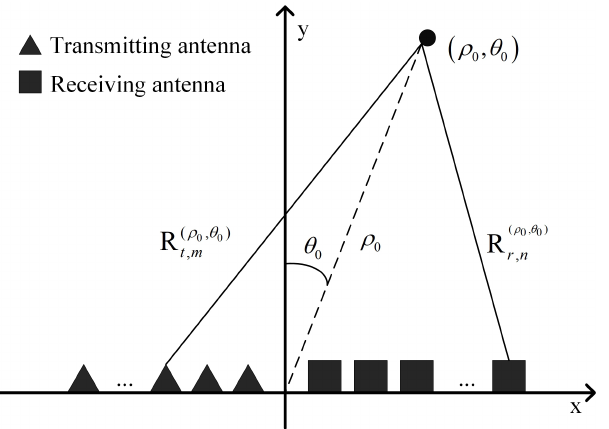
Figure 3. Geometric model of data collection for one-dimensional linear array MIMO